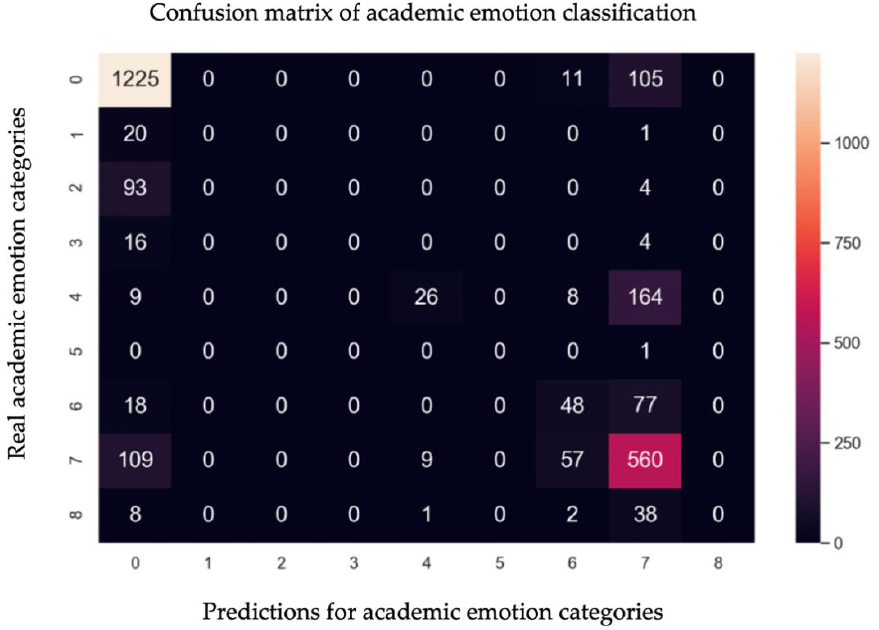
Figure 10. Confusion matrix of academic emotion classification.